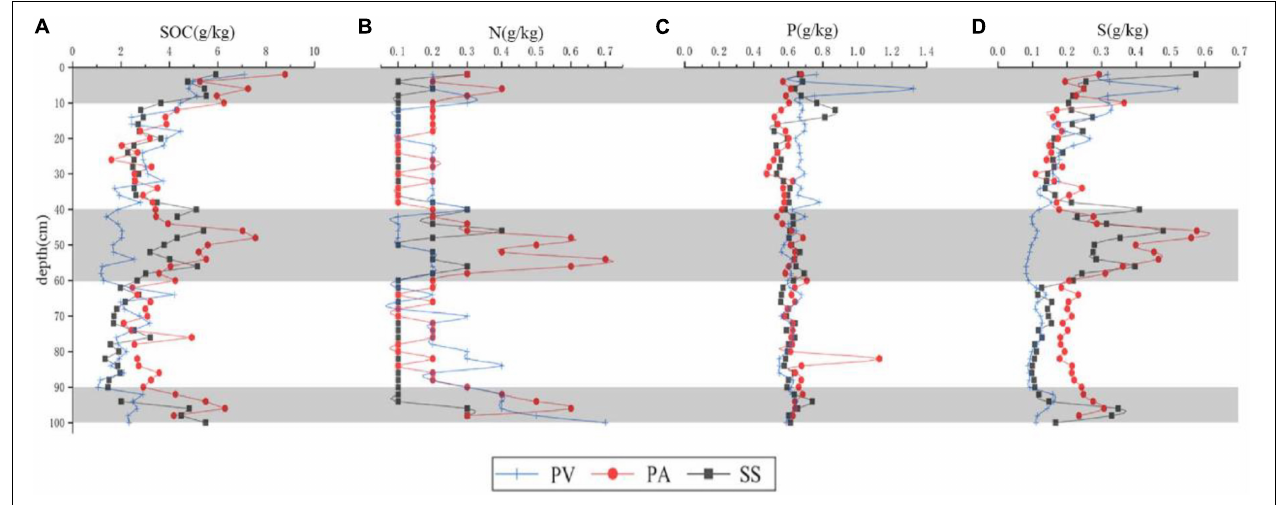
FIGURE 2 | Changes in the contents of C (A) , N (B) , P (C) , and S (D) along different soil profiles in PV, PA, and SS